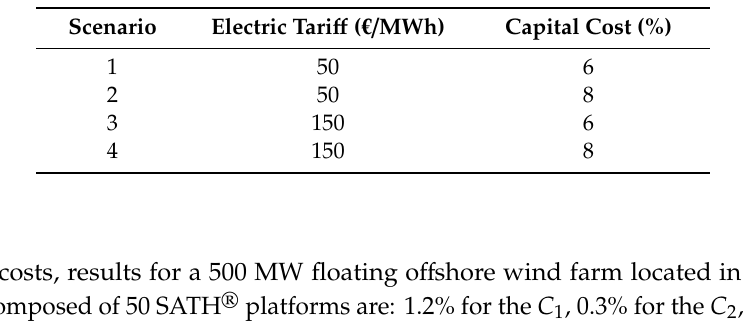
Table 3. Scenarios analyzed for the SATH ® platform.